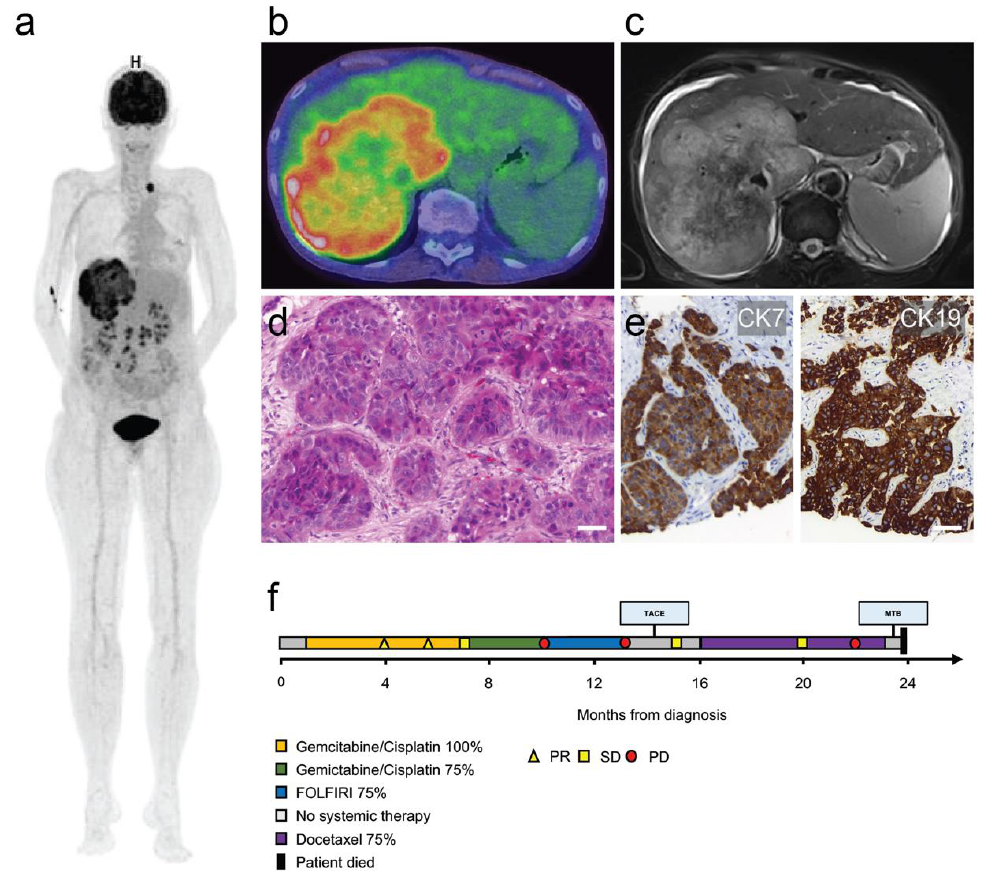
Figure 1. Imaging, histology and clinical course. ( a ) Three-dimensional positron emission tomography–computed to- mography reconstruction showing the large primary tumor mass in the right liver lobe and a left supraclavicular nodal metastasis. ( b ) PET/CT overlay axial section of primary liver tumor. ( c ) Corresponding axial T2-weighted magnetic resonance imaging section. ( d ) Histological section of the nodal metastasis with infiltrates of poorly differentiated cholan- giocarcinoma. ( e ) Cytokeratin 7 (CK7/left panel) and cytokeratin 19 (CK19/right panel) immunohistochemistry of primary tumor. Scale bars = 50 µ m. ( f ) Swimmer plot illustrating clinical course (PR = partial response, SD = stable disease, PD = progressive